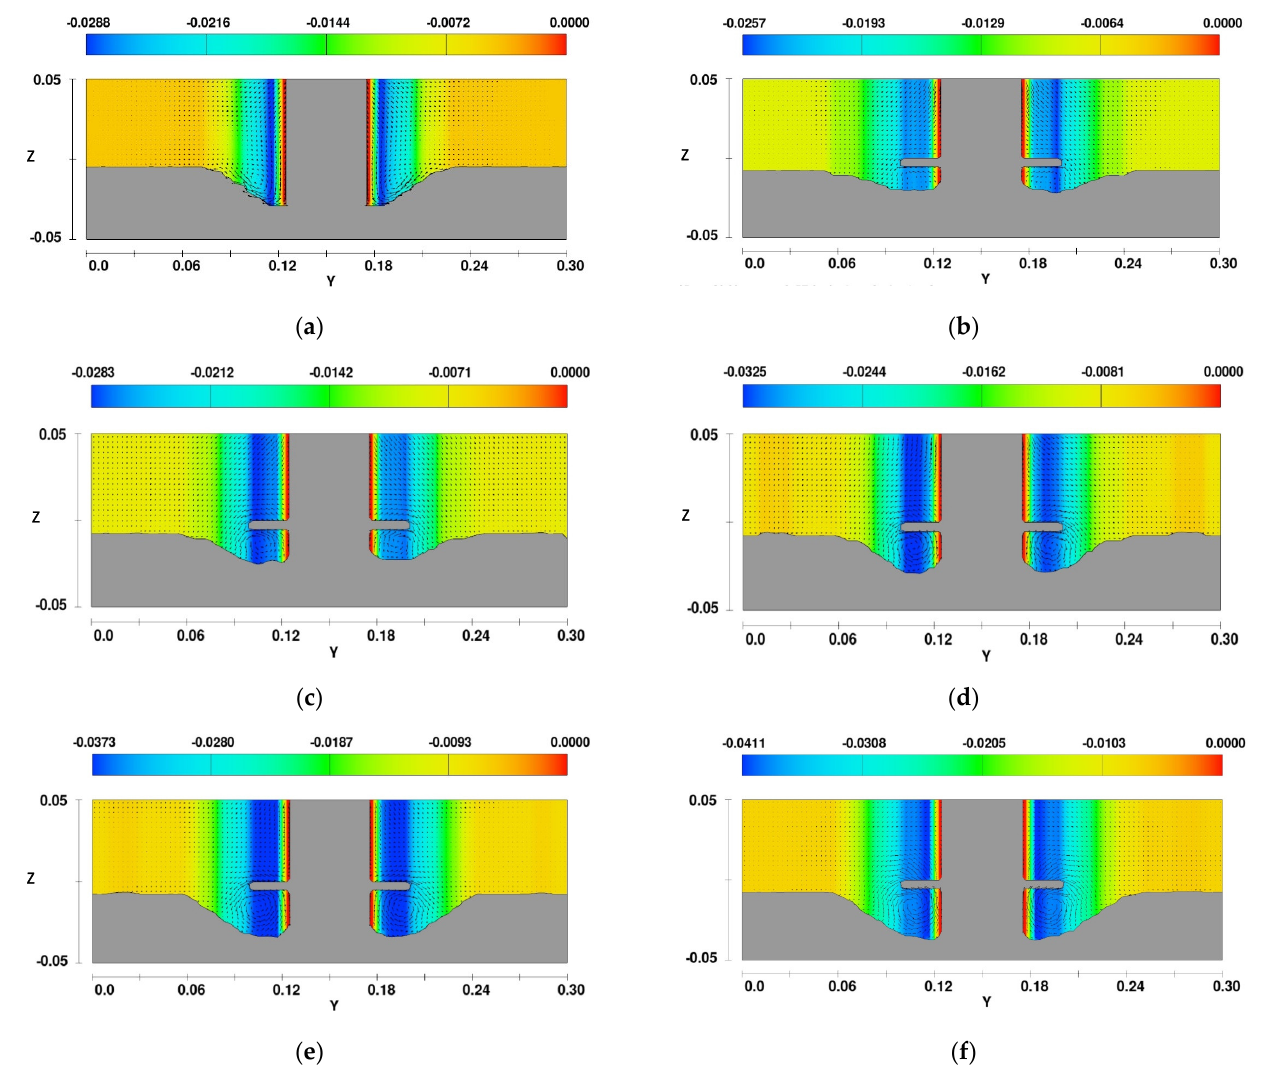
Figure 10. The scouring depth and vectors at x = 0.762 m (the center of the pier, t = 400 s) of each case (unit: m). ( a ) Case 1 (without circular collar). ( b ) Case 2 (θ = 0°). ( c ) Case 3 (θ = 5°). ( d ) Case 4 (θ = 10°). ( e ) Case 5 (θ = 15°). ( f ) Case 6 (θ = 20°).